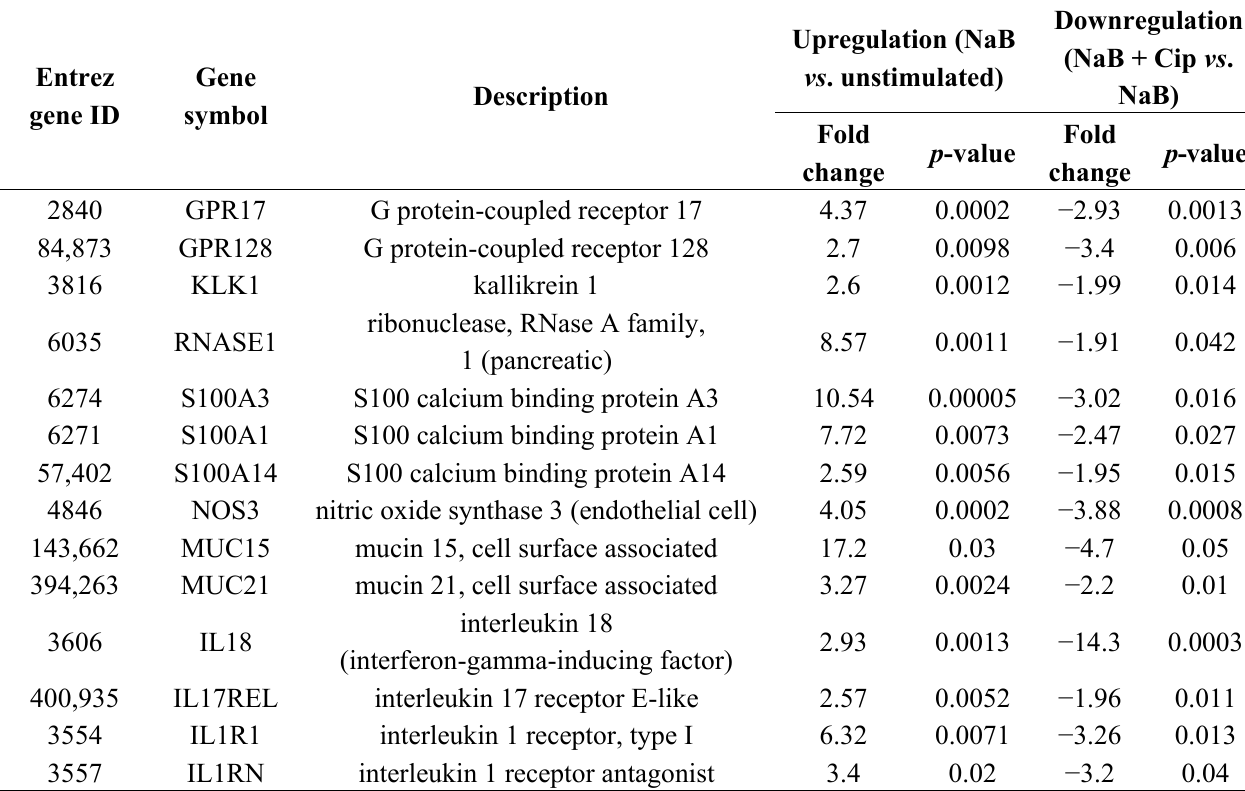
Table 1. Selected Genes, up-regulated with NaB treatment and subsequently suppressed with co-administration of